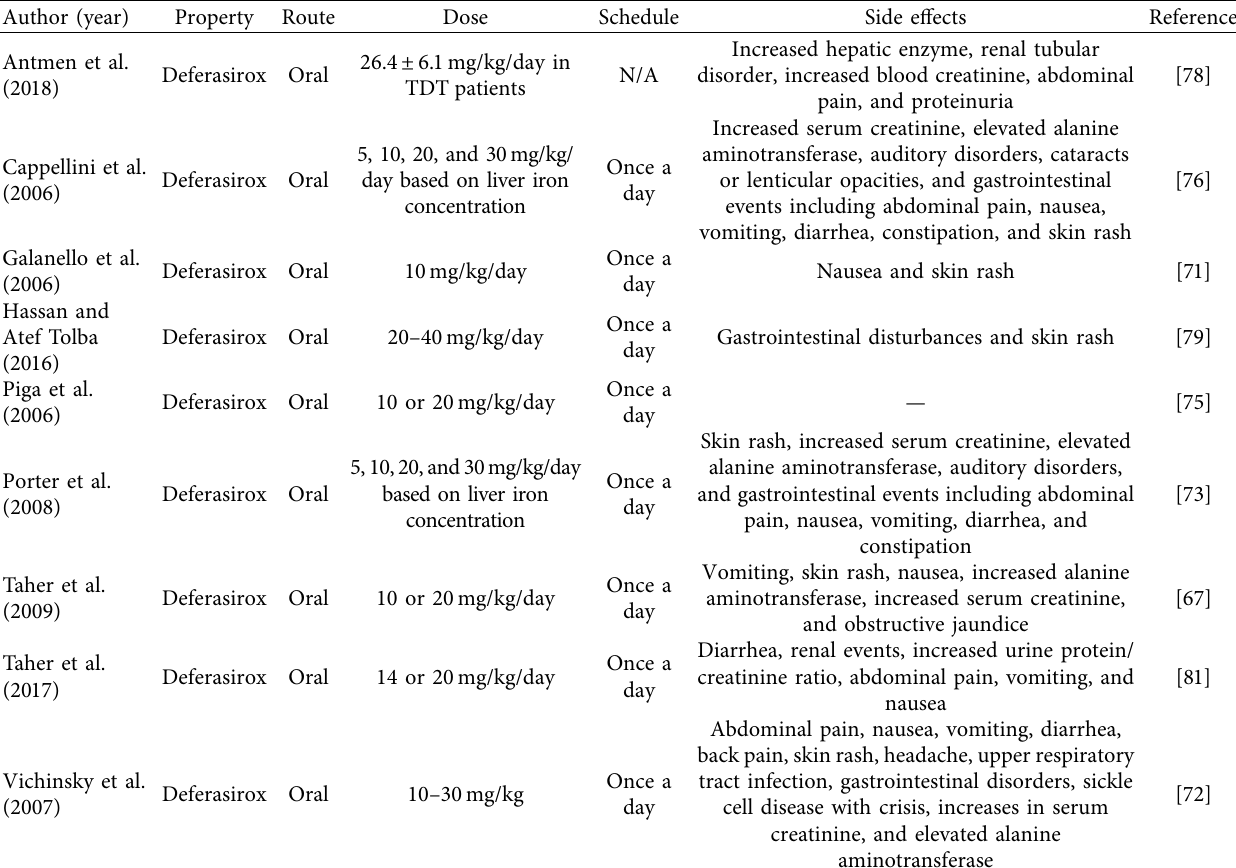
Table 3: Summary of the findings on